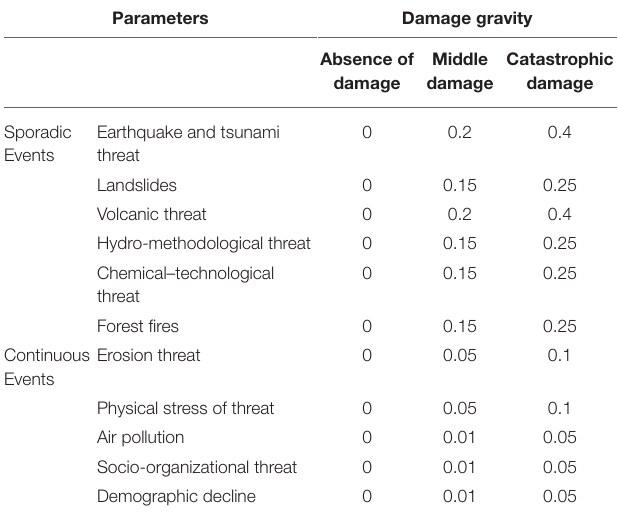
TABLE 1 | Scenario description and classification of threats according to damage severity. Parameters